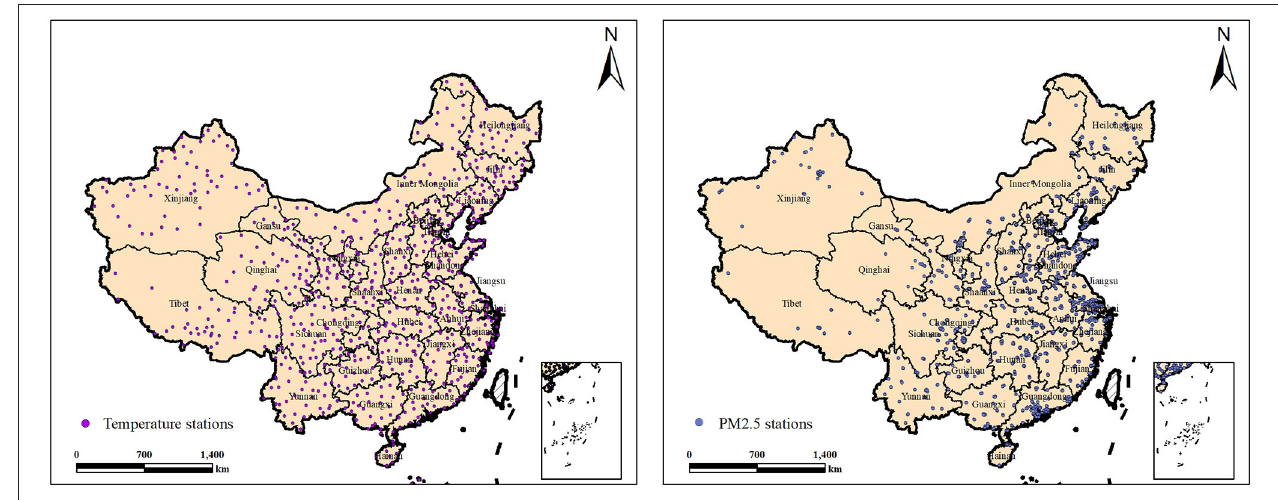
FIGURE 4 | Location of temperature and PM 2.5 monitoring